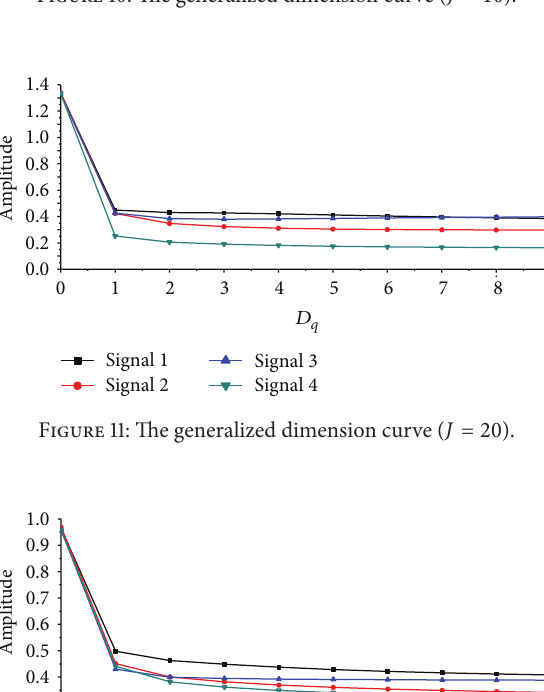
Figure 10: The generalized dimension curve ( 𝐽 = 10 ).